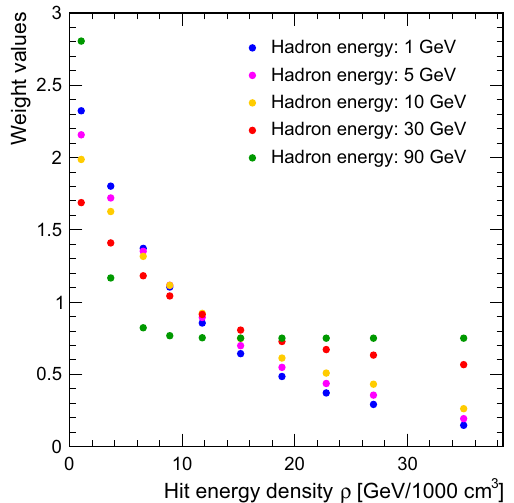
Fig. 3 Software compensation weights as a function of hit energy den- sity for different hadron energies, derived from Eq. 1